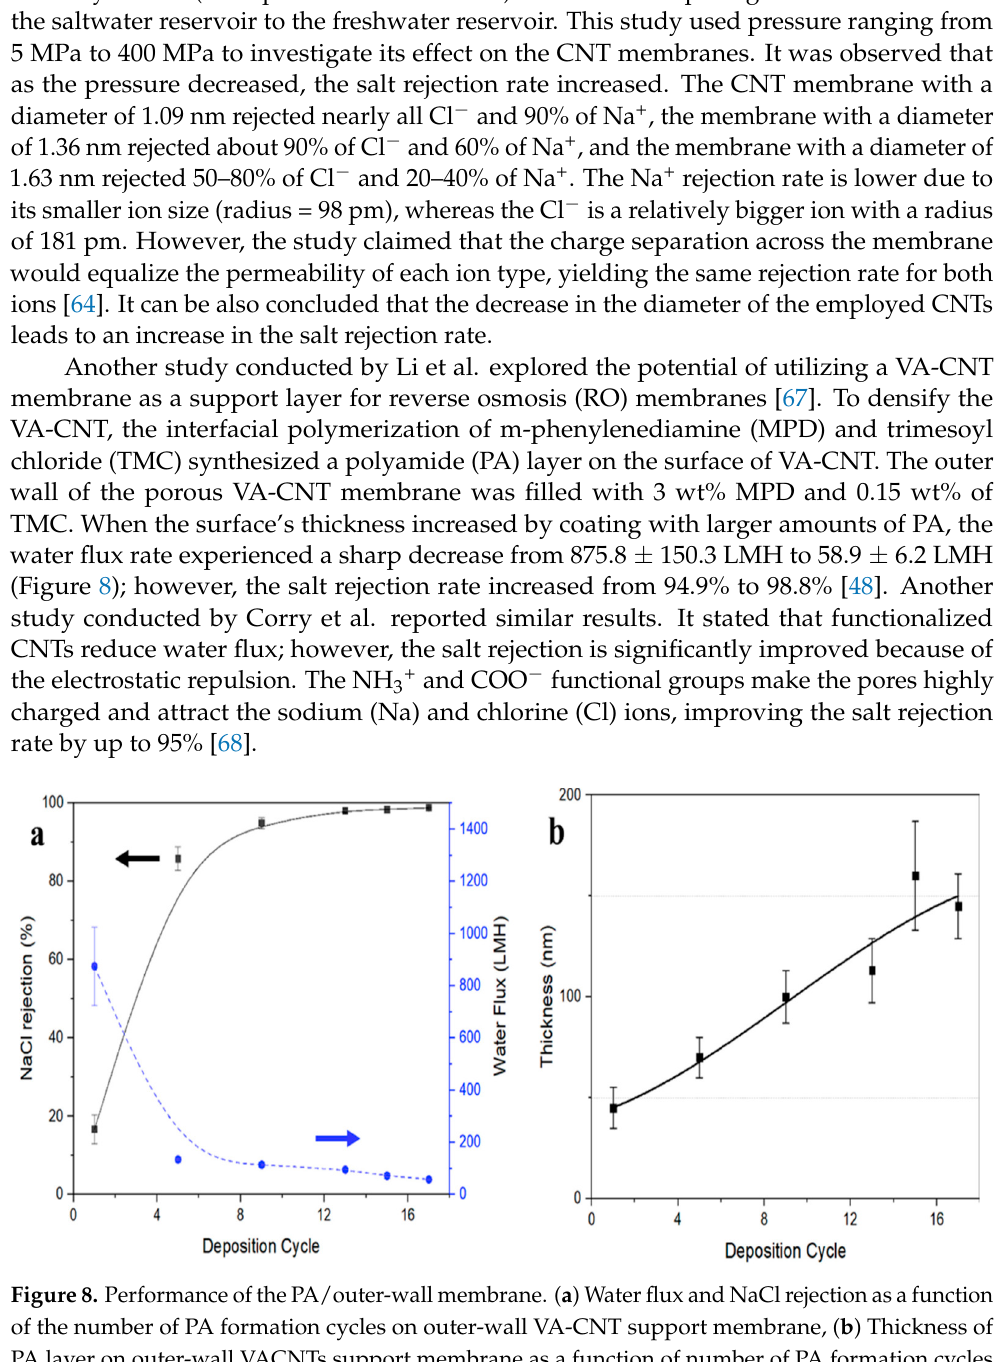
Figure 7. Salt rejection vs. time graph for different CNT densities of VA-CNT membranes (density is given in number of nanotubes/cm 2 ) [63].